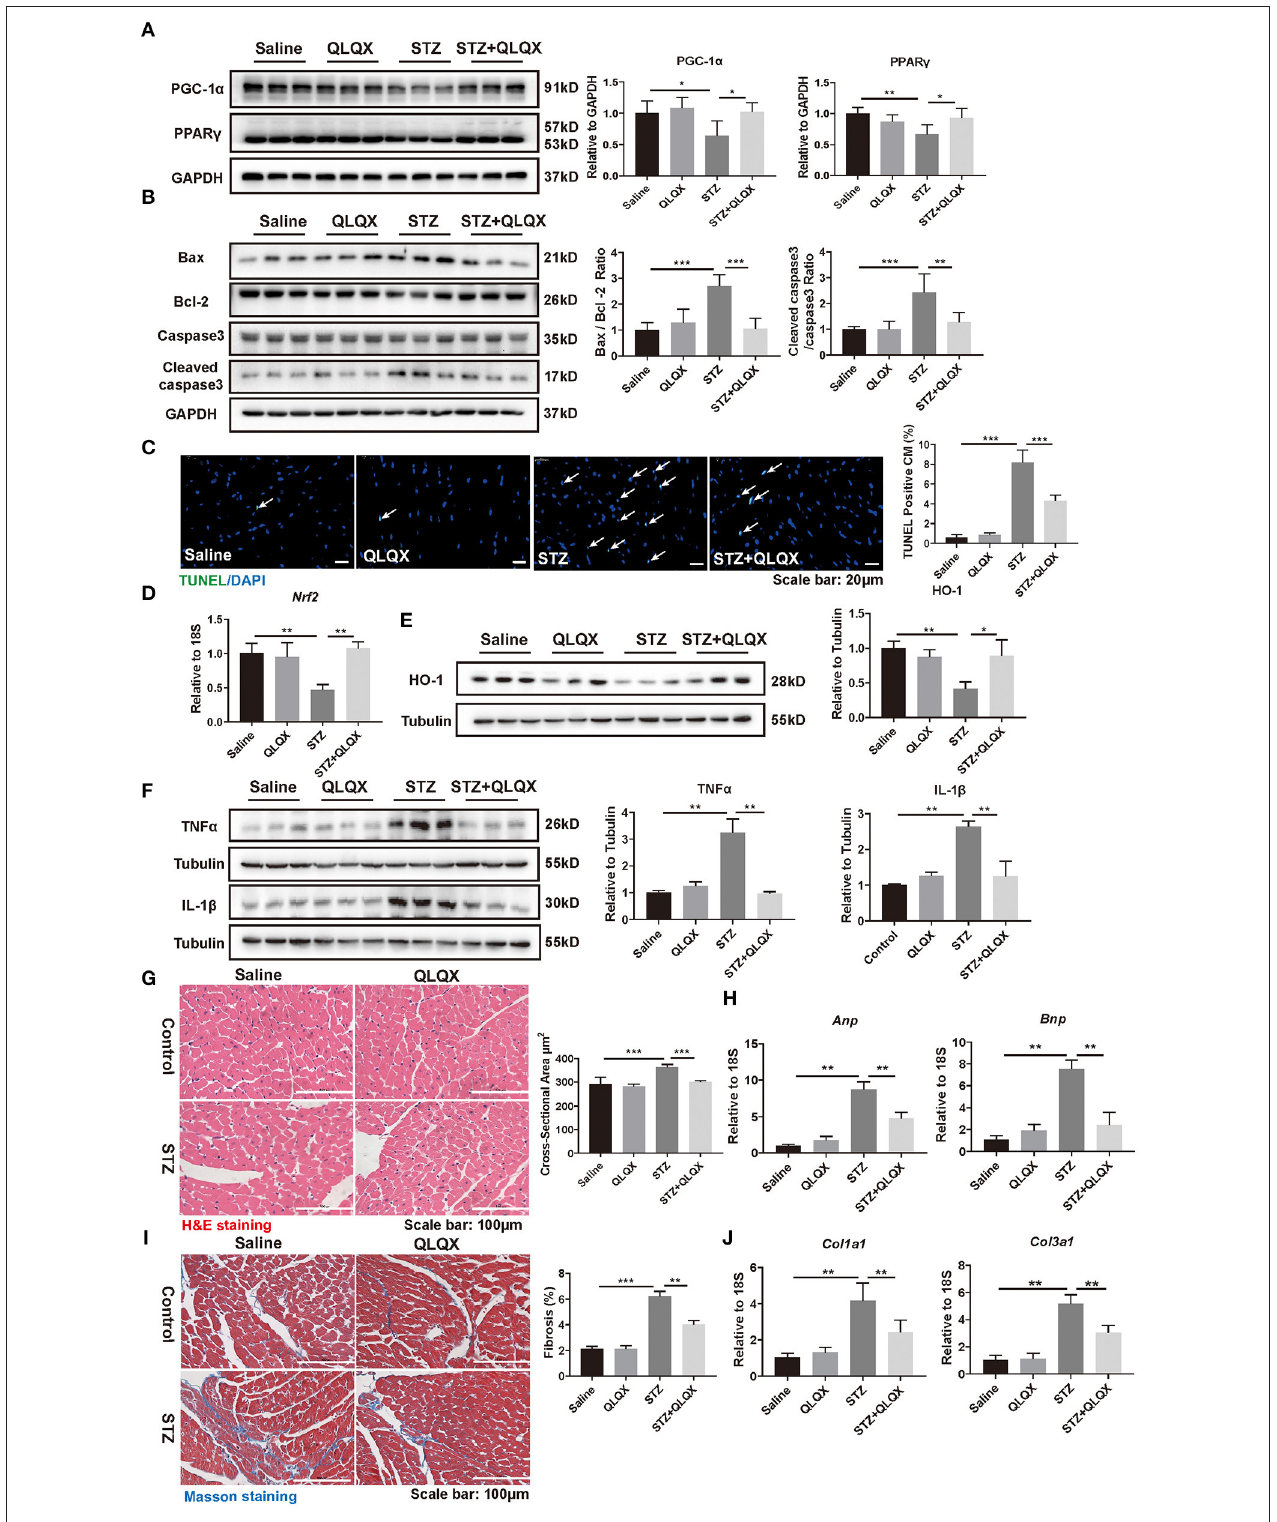
FIGURE 5 | QLQX alleviated STZ-induced cardiac pathological remodeling. (A) Western blot analysis of the expression level of PPAR γ and PGC-1 α in STZ-induced diabetic cardiomyopathy mouse heart tissue, indicated in groups ( n = 6). (B,C) Western blot analysis ( n = 6) and TUNEL assay ( n = 6, 6, 6, and 7) suggested